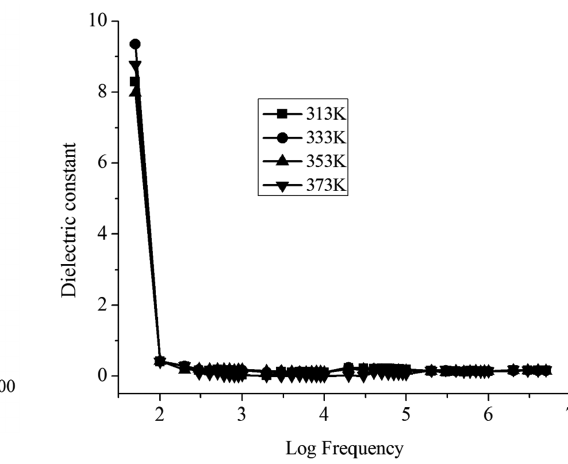
Figure 8. Dielectric constant versus log frequency of LCHB